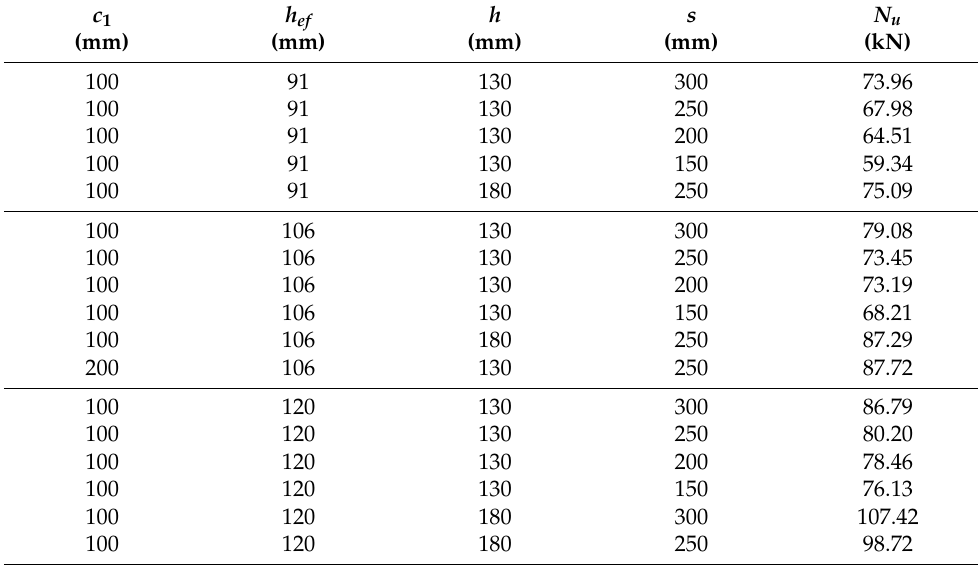
Table A1. Numerical results—plain concrete slabs (reference models, f c = 20 N/mm 2 ).